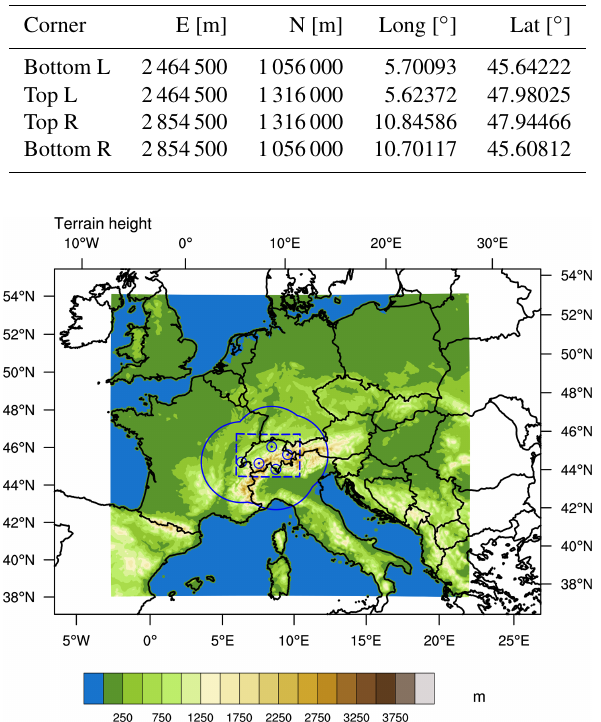
Figure 1. Terrain heights (above sea level) for points covered by the WRF simulation outer domain. Black lines show national bor- ders and coastlines. The locations of the five MeteoSwiss radars are indicated with blue circled points, and the solid blue line shows the approximate radar domain. The dashed blue line shows the study domain. Storms with centre points outside the study domain are not considered in this study. Elevations below 0.001m are plotted in blue. Plot produced using the NCAR Command Language (NCL) version 6.6.2.